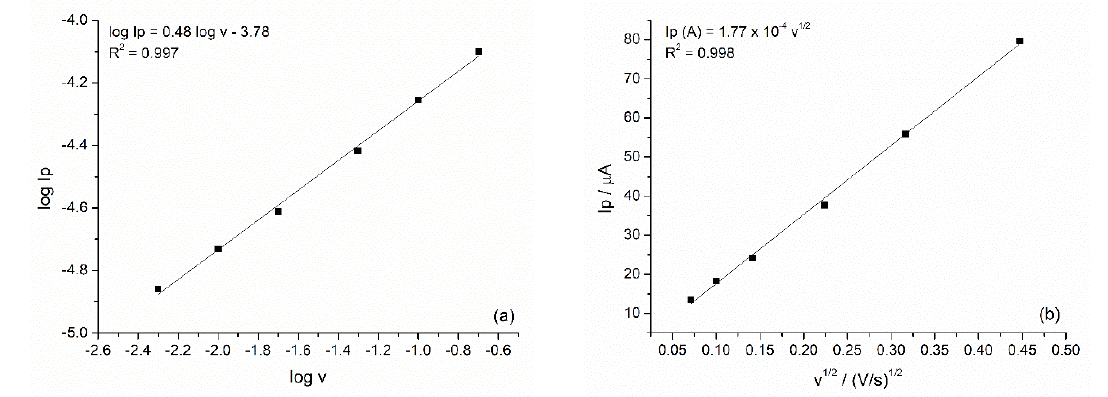
Figure 4. Kinetic studies. ( a ) Dependence of the logarithm of the peak current on scan rate logarithm. ( b ) Dependence of peak current on square-root of scan rate.